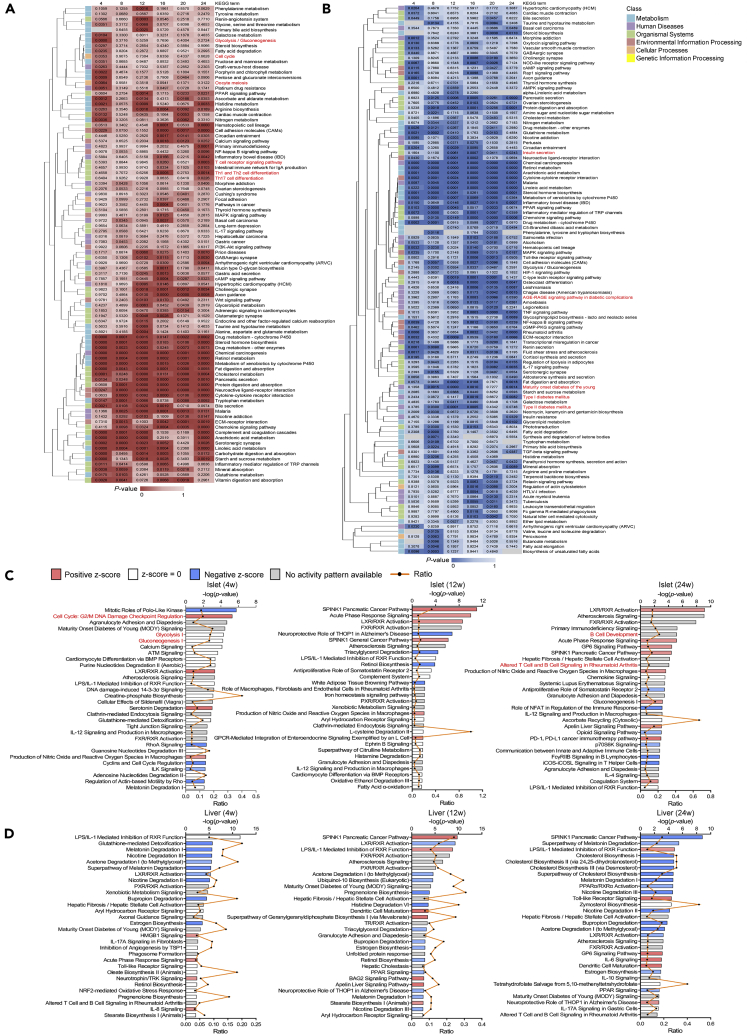
Temporal pathway enrichment analyses of DEGs(A and B) Clustered heatmaps of islets (A) and liver (B) showing KEGG pathway enrichment analyses of DEGs across six time points. The top 40 enriched KEGG pathways ordered in a decreasing level of significance (p value, Fisher's exact test) were first identified in islets and liver at each time point. We then took the union of six time points and clustered by columns using average linkage method. The intensity of color represents p value.(C and D) IPA of islets (C) and liver (D) presenting the top 30 canonical pathways (y axis) modulated by DEGs at week 4, 12, and 24 of diet. These IPA pathways were sorted by the significance of association between dataset and canonical pathway (log of p value, Fisher's exact test, top x axis). The ratios of genes that map to each canonical pathway (bottom x axis) were also presented.See also Figure S7 and Table S1.